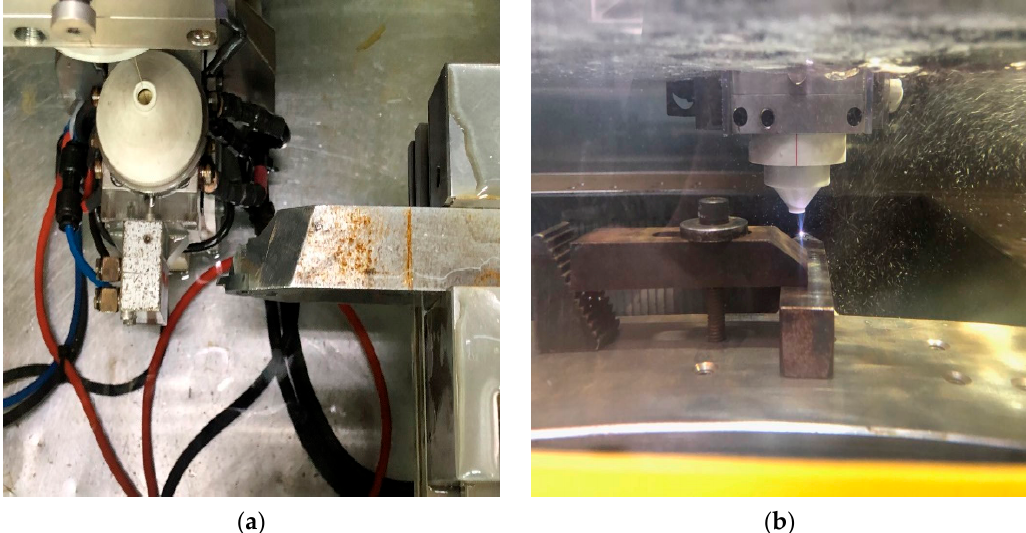
Figure 4. ( a ) Calibration of the machine before EDM sharpening of the cutting insert; ( b ) Cutting process of PCD insert with EDM machining technology.